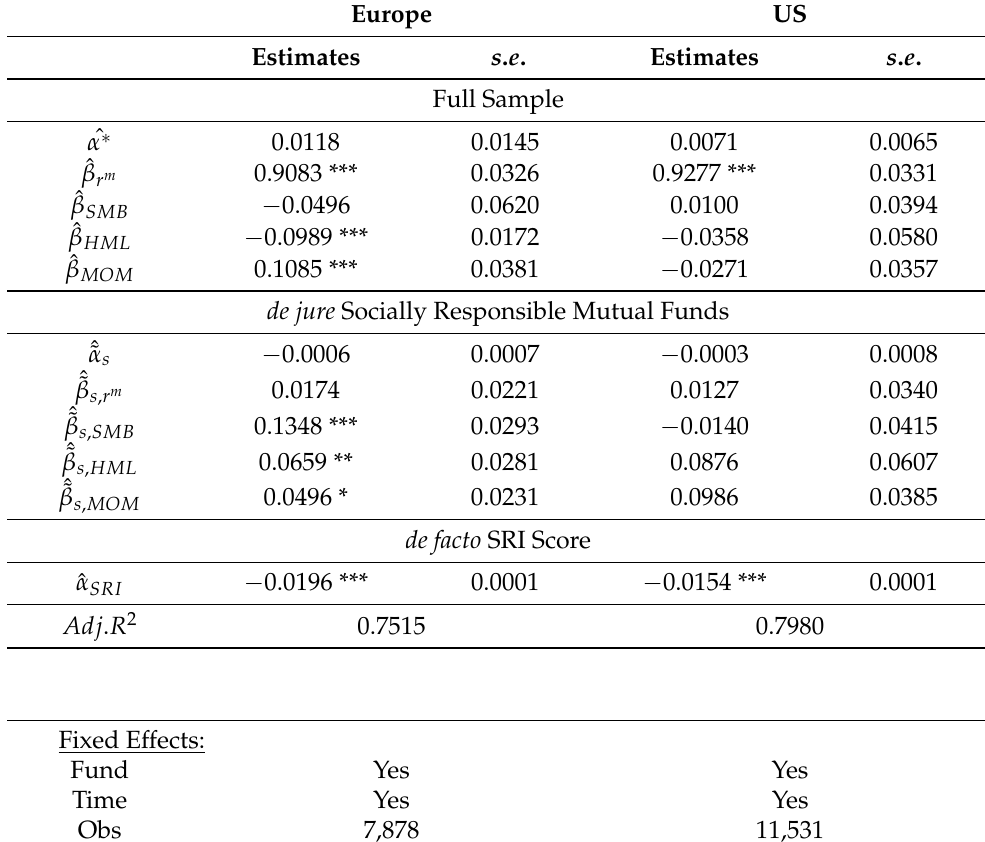
Table 9. Dynamic (time-varying SRI ratings) estimation of the augmented nonlinear panel version of Carhart’s model